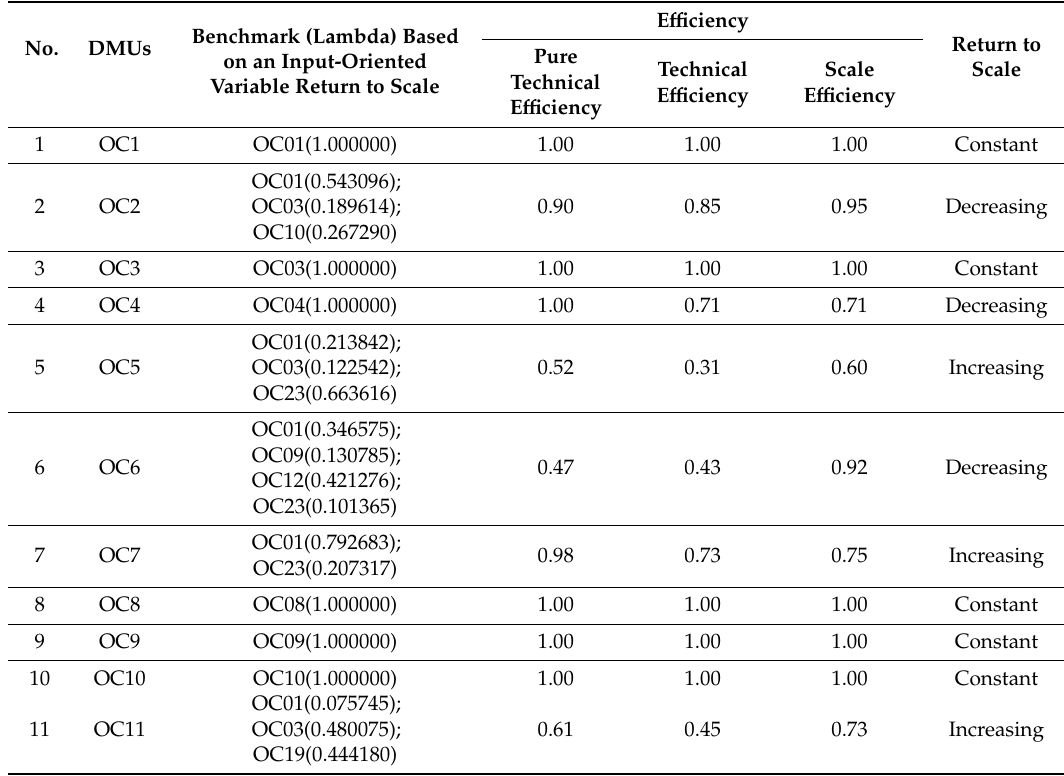
Table 2. The input-oriented data envelopment analysis (DEA) e ffi ciency result for opencast mines. DMU: decision making